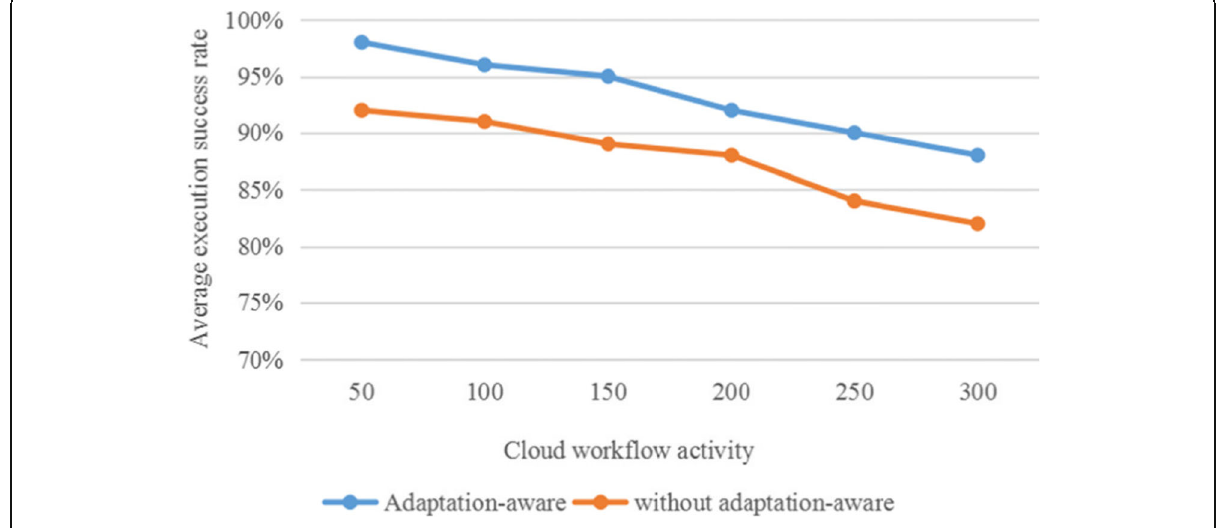
Fig. 6 Effect of adjusting the perception policy on execution success